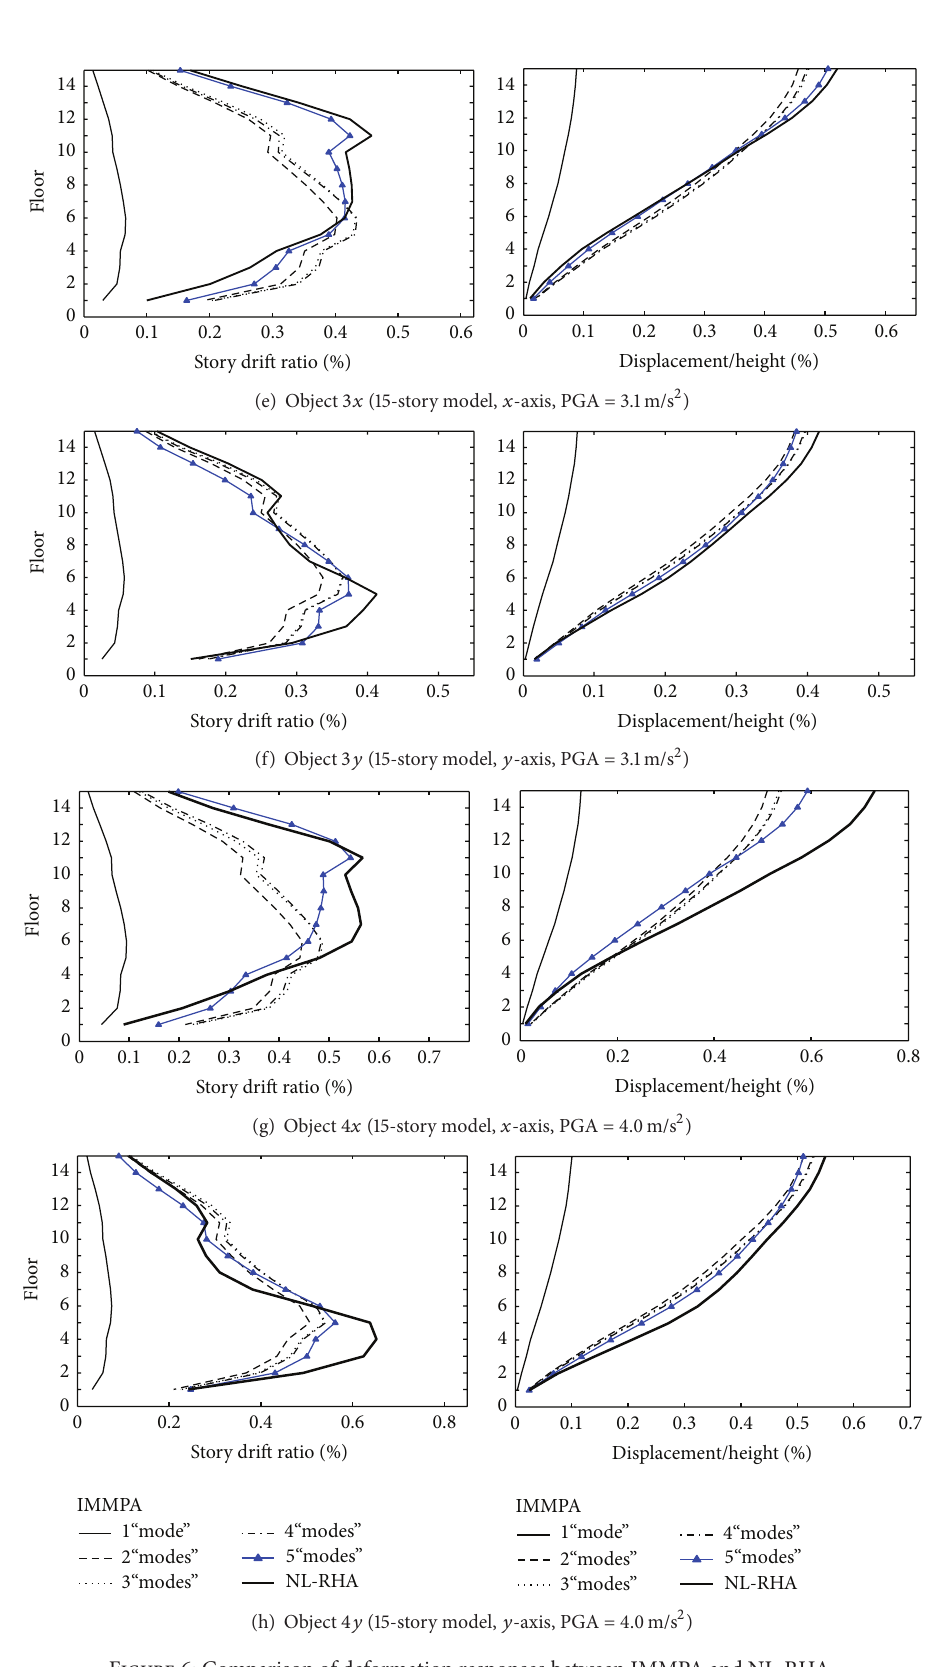
Figure 6: Comparison of deformation responses between IMMPA and